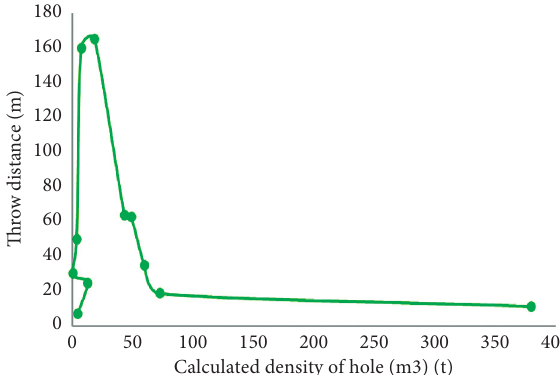
Figure 10: Point line diagram of the calculated density and throw distance.